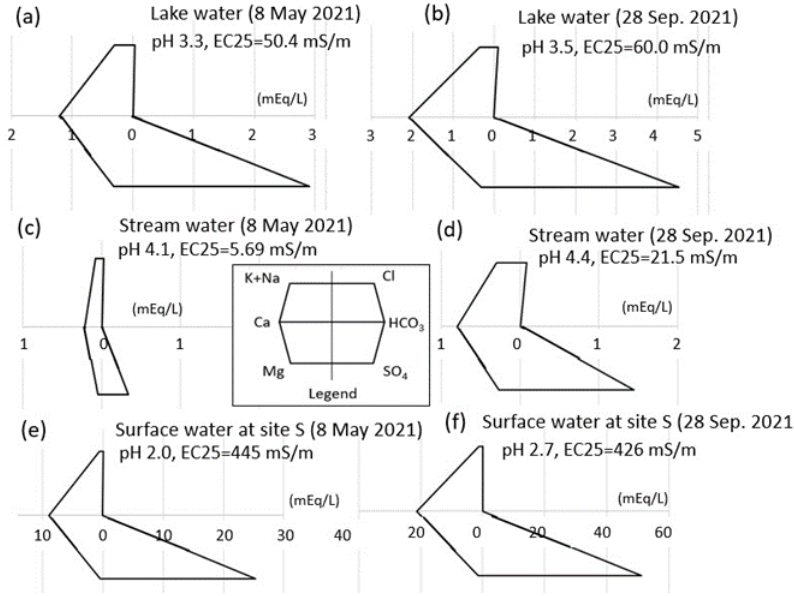
Figure 3. Stiff diagrams of ( a , b ) lake surface water, ( c , d ) Goshiki Stream water, and ( e , f ) spring water from the volcanic silty layer (site S in Figure 1). The ( a , c , e ) waters were sampled on 8 May 2021, and the ( b , d , f ) waters on 28 September 2021.